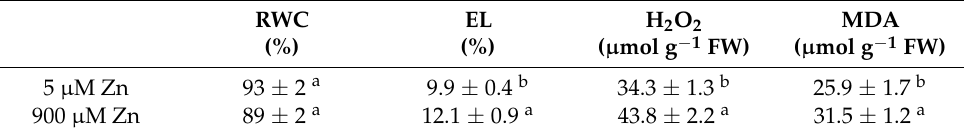
Table 1. Effects of 5 µM (control) or 900 µM (excess) Zn exposure for 8 days on the relative water content (RWC), electrolyte leakage (EL) and the contents of hydrogen peroxide (H 2 O 2 ) and malondialdehyde (MDA) in the leaves of Salvia sclarea.